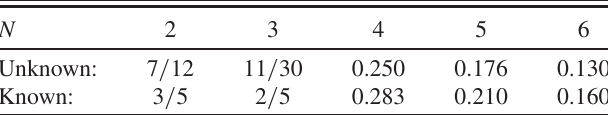
TABLE II. The success probability P cl s for d ¼ 3 and data string lengths N ¼ 2 ; … ; 6 in the cases of known and unknown distributions P and Q . For unknown distributions, the values are computed using Eq. (F13) in Appendix F. For known distributions, the values are given by Eq. (G7). The table shows that knowing P and Q increases the success probability of